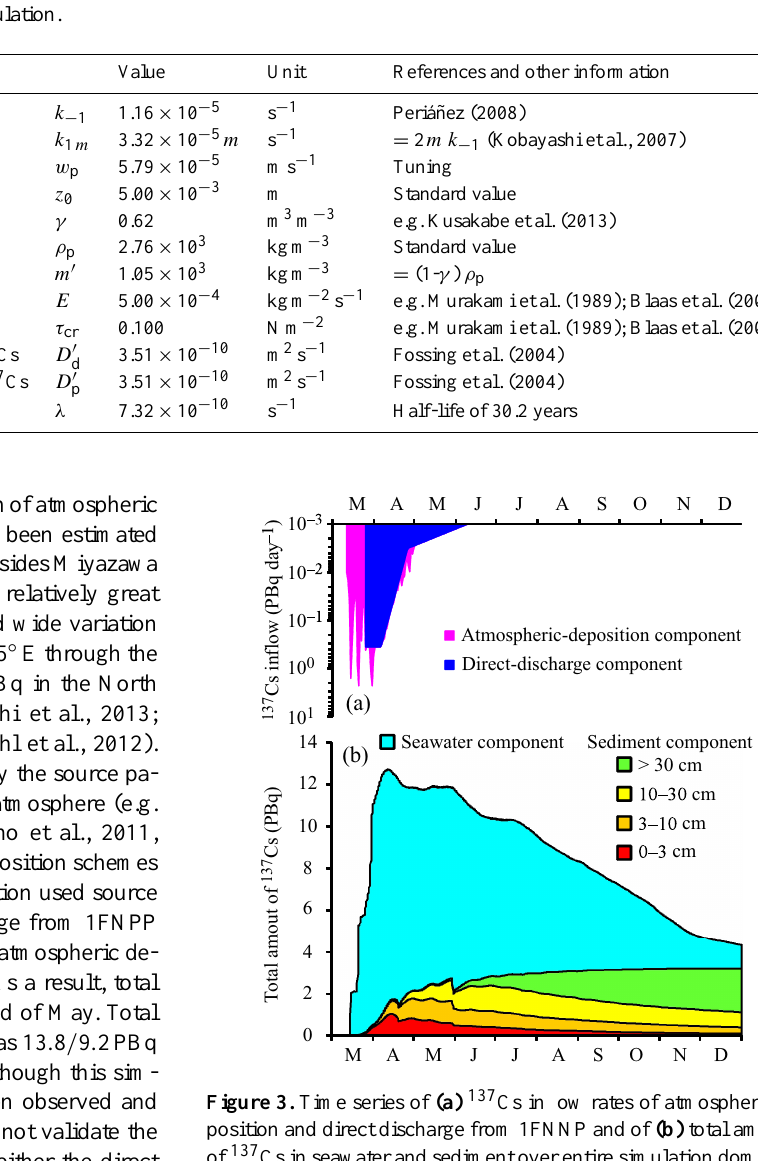
137 Cs model described in Sect. 2.4, were specified. At the lateral boundaries, the three variables in the Region-1 simu- lation were set to 0. We used the hourly Region-1 results in the Region-2